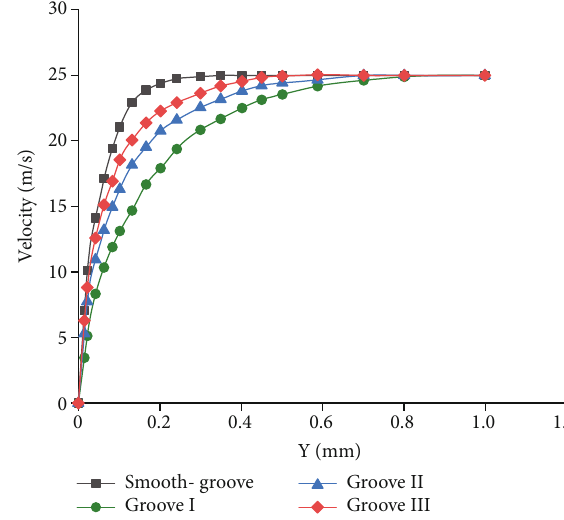
ISmooth- groove Groove II Groove Groove Figure 12: Velocity distributions along longitudinal